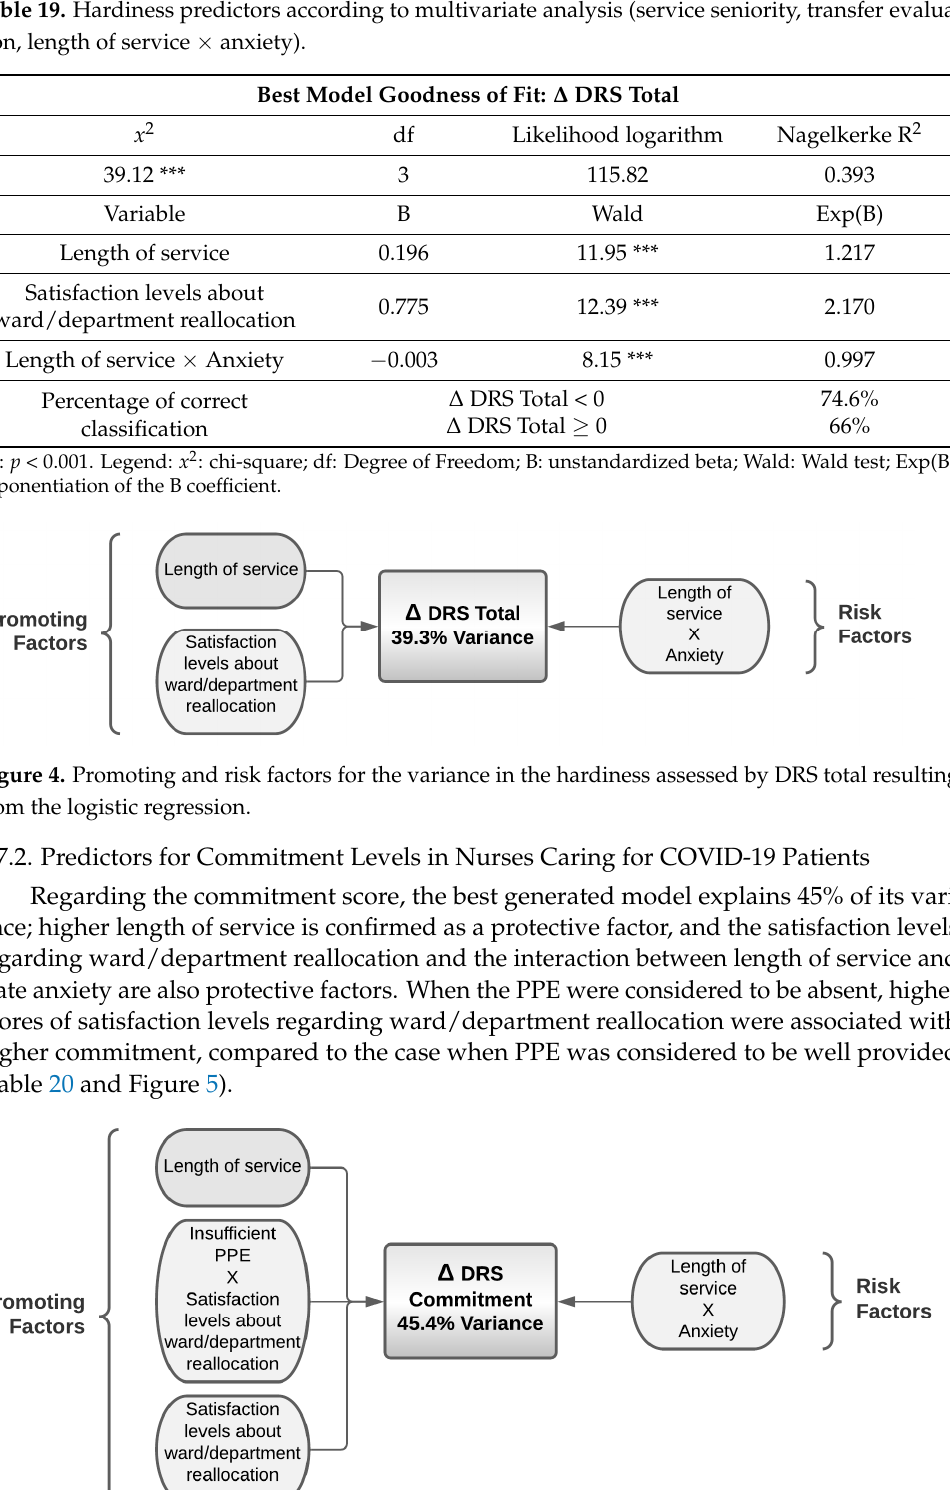
Table 19. Hardiness predictors according to multivariate analysis (service seniority, transfer evalua- tion, length of service × anxiety).